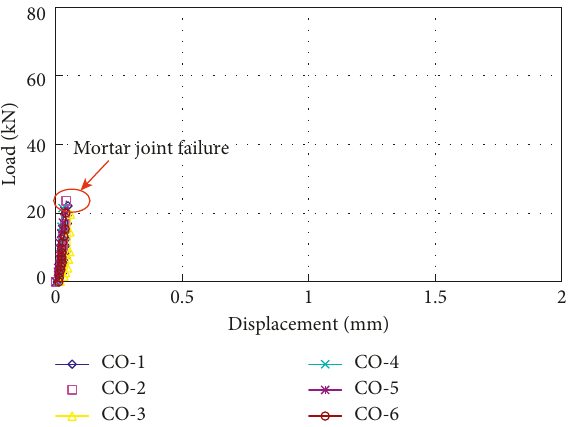
Figure 11: Load-displacement response of group CO.